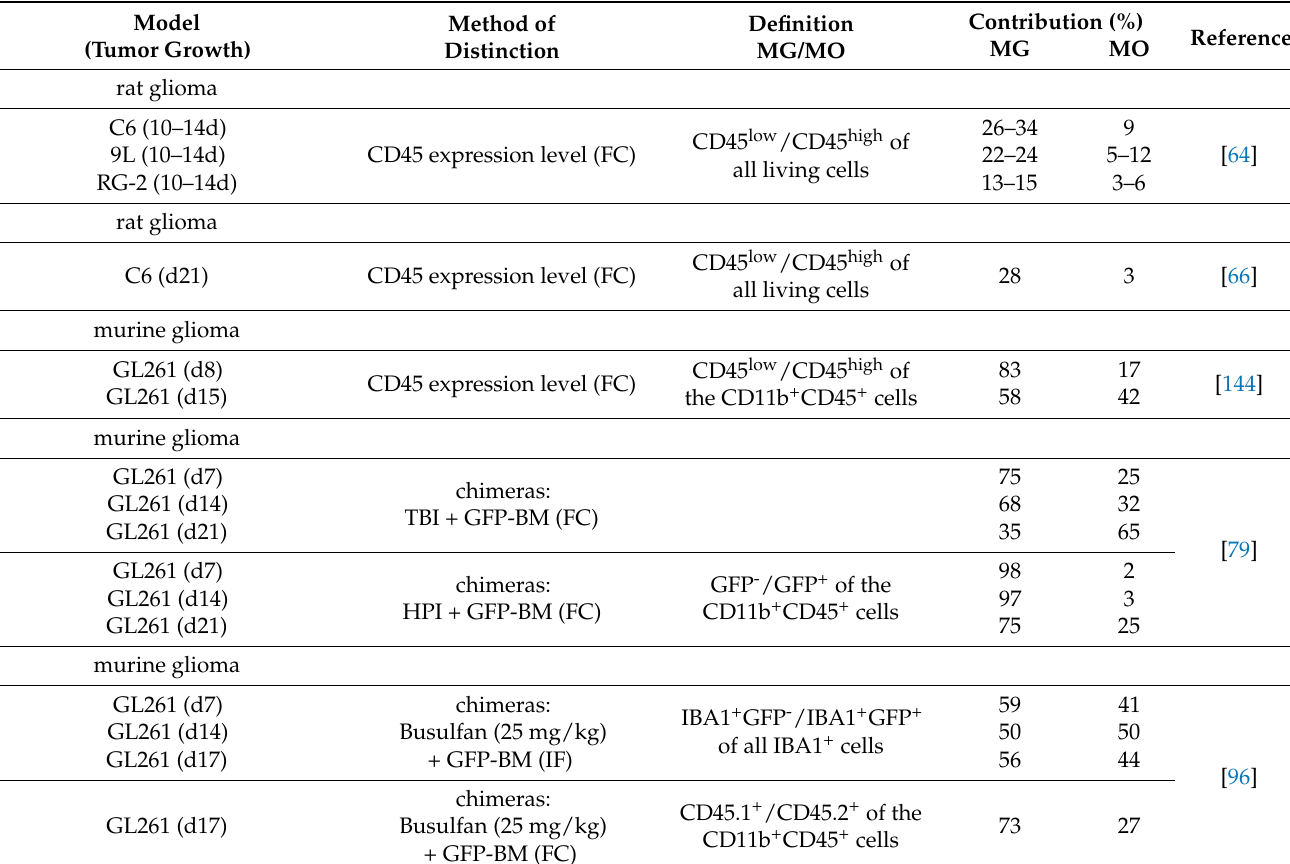
Table 1. Contribution of microglia (MG) and macrophages (MO) to glioma tissues.